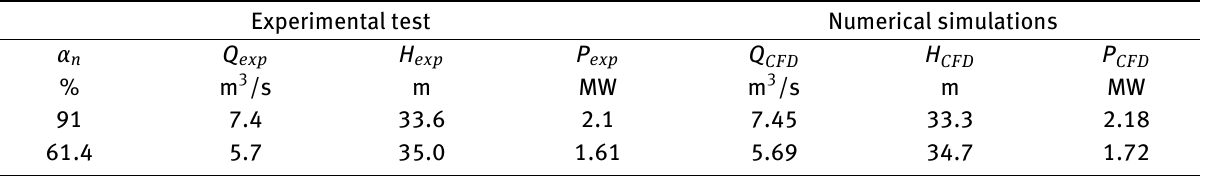
Table 2: The validation of the numerical model Experimental test Numerical simulations